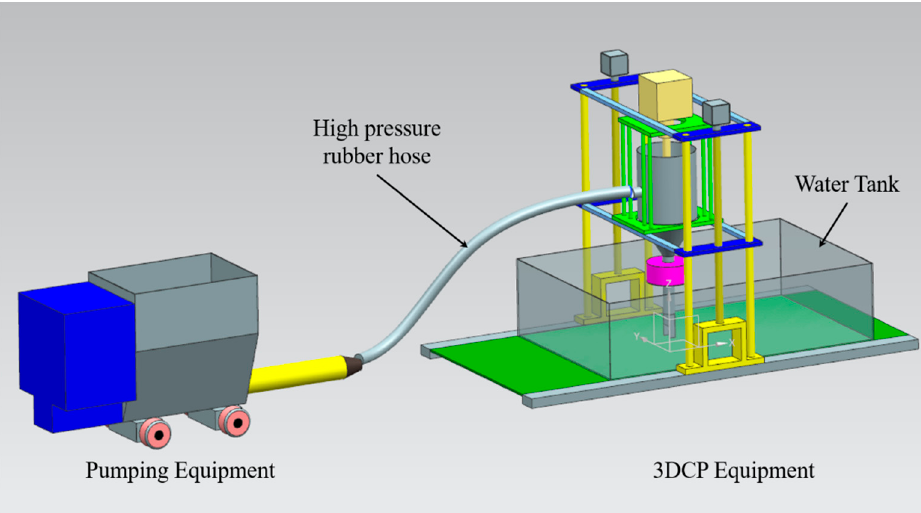
Figure 2. The concept model of 3DCP system for the underwater printing.